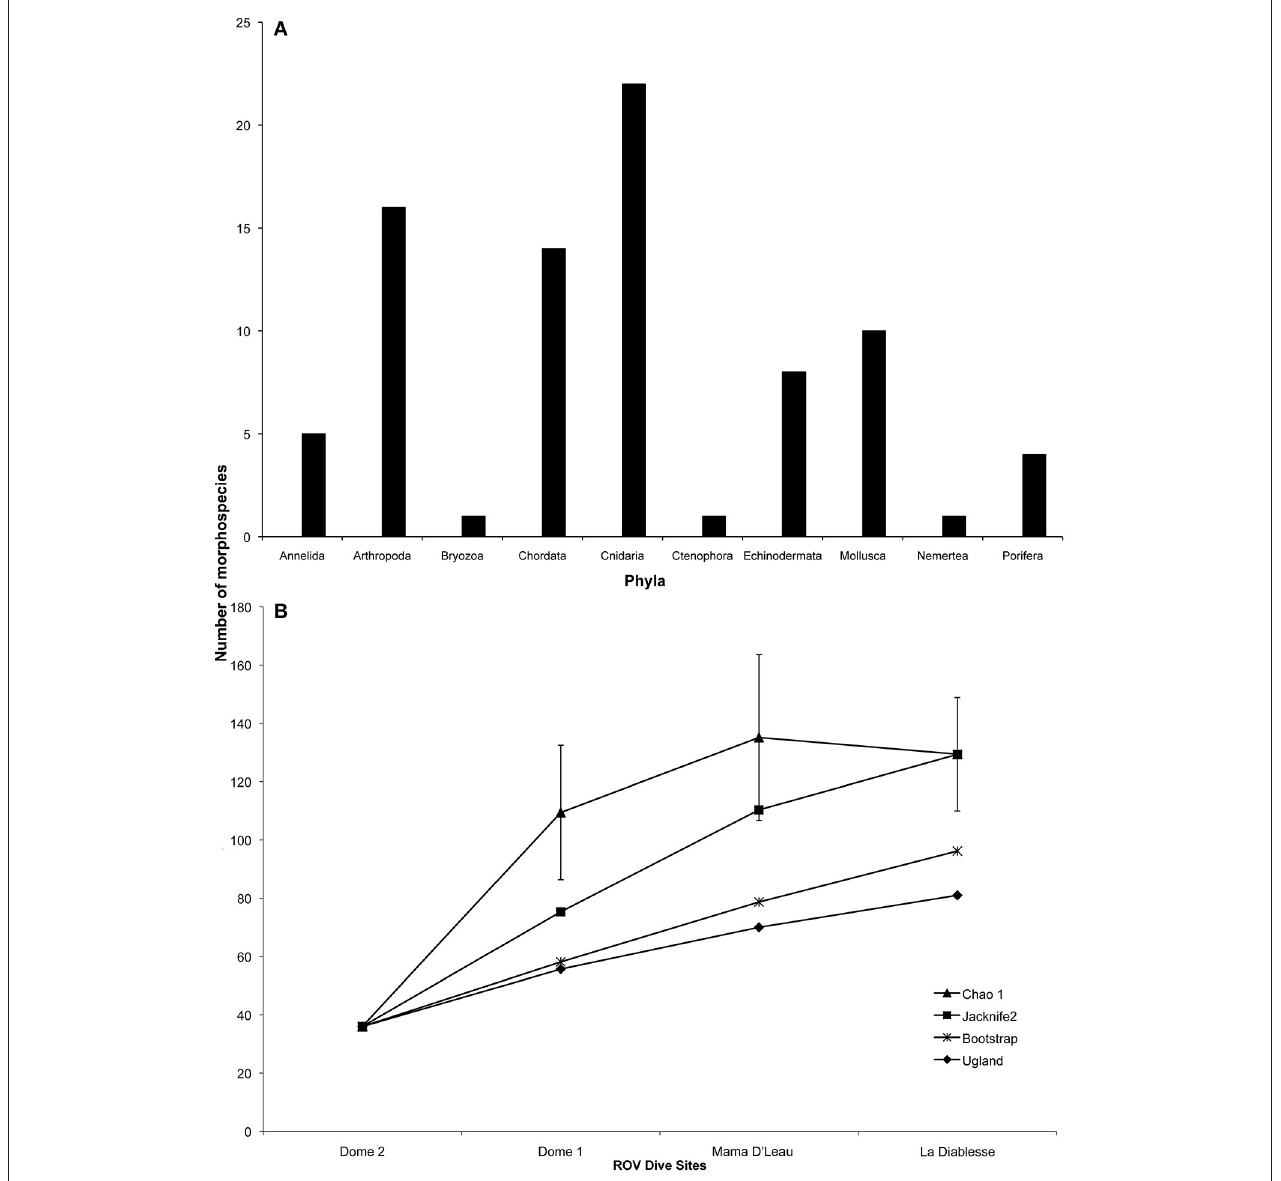
FIGURE 4 | Megafaunal morphospecies richness observed at El Pilar off Trinidad and Tobago. (A) Megafaunal morphospecies richness by phylum. (B) Chao-1 ( ± s.d.), Jacknife2, Bootstrap, and Ugland (UGE) estimates of megafaunal morphospecies richness with increasing number of ROV dive